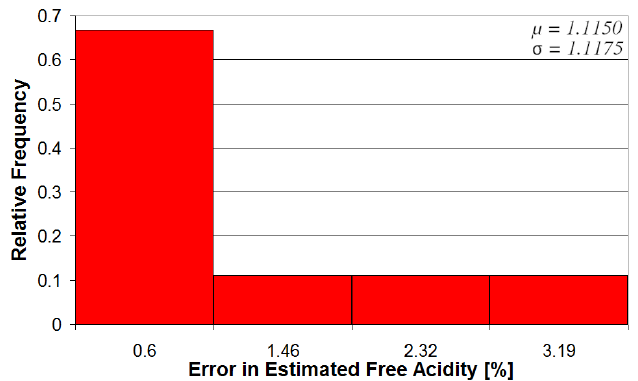
Figure 7. Histogram for the error in the estimated free acidity in the case of oxidized samples (i.e., samples featuring a peroxide index > 20 meq O 2 /kg).